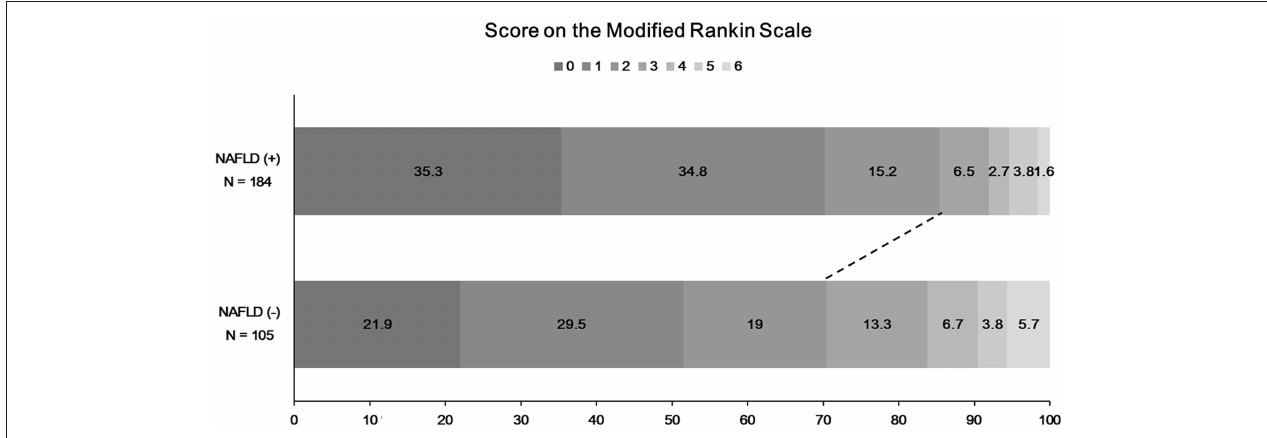
FIGURE 3 | Distribution of functional outcome at 90 days according to the presence of NAFLD. A total of 32 patients without modified Rankin scale (mRS) scores in 90-day data were excluded. NAFLD, non-alcoholic fatty liver disease; mRS, modified Rankin